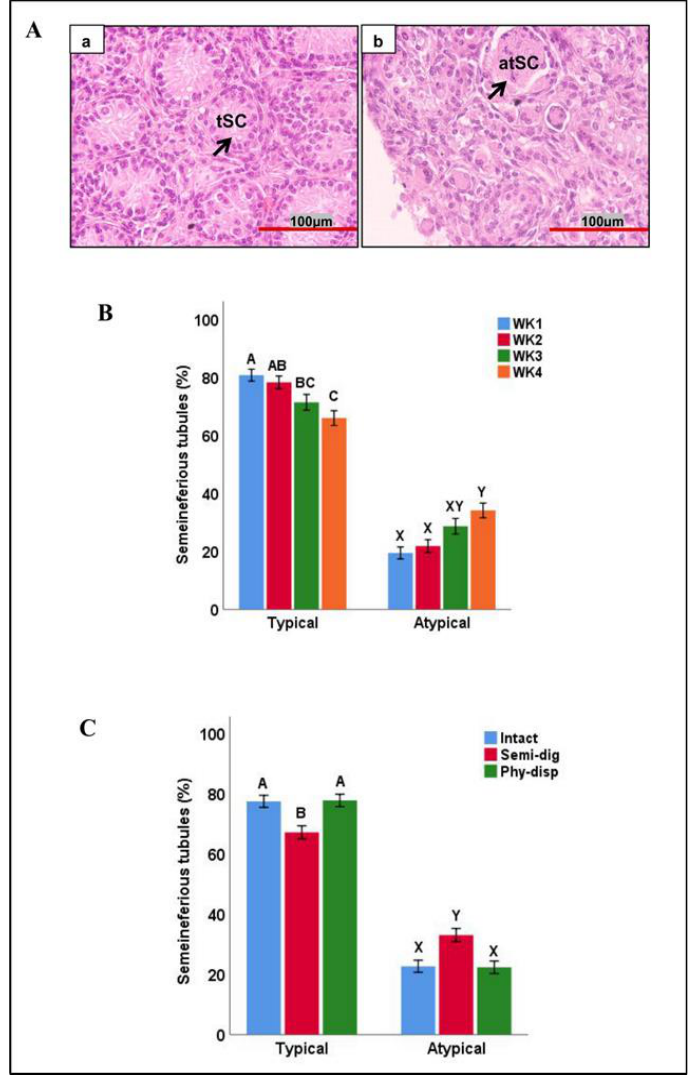
Figure 5. Morphology and percentage of different seminiferous cords in testicular tissue fragments during culture. ( A ) Representative photomicrographs demonstrating the morphology of seminiferous cords during in vitro culture. ( a ) Typical (tSC) seminiferous cords (arrow) in cultured tissue fragments, referring to those with a normal morphology as expected in a normal neonatal pig testis. ( b ) Atypical (atSC) seminiferous cords (arrows) in cultured tissue fragments, referring to those that did not conform to a typical morphology as expected in a normal neonatal pig testis. ( B ) The percentage of seminiferous cords displaying either morphology at different time points during culture. Overall, the parentage of typical seminiferous cords decreased, while that of atypical cords increased over time. ( C ) The percentage of seminiferous cords with either morphology in fragments undergoing each method of preparation. Intact and physically dispersed (Phy-disp) methods of fragment preparation had more typical cords and less atypical cords than semi-digested (sem-dig) method. Data with different letters within each cord morphology differ significantly ( p < 0.05).